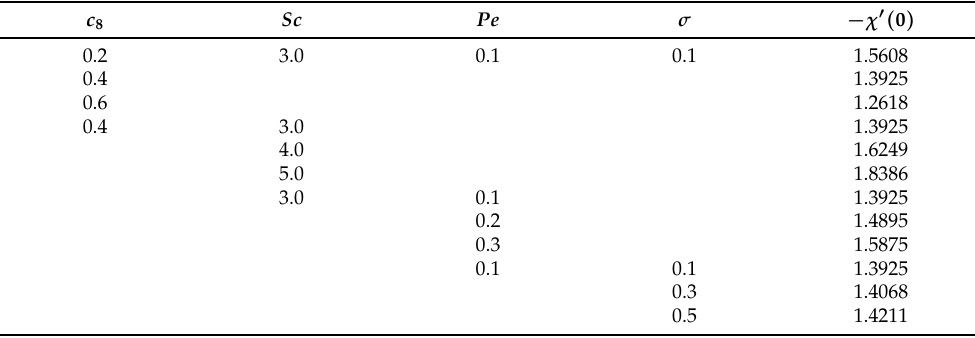
Table 5. Results for − χ (cid:48) ( 0 )